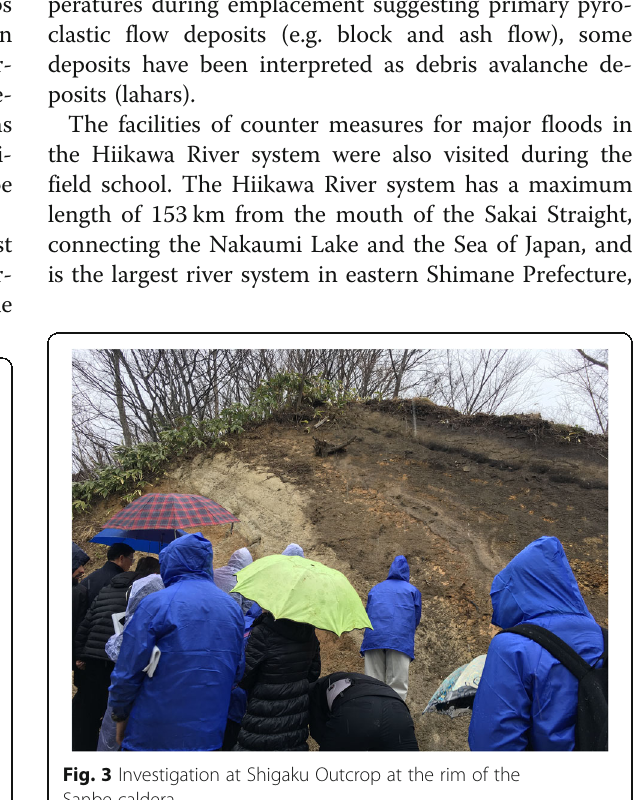
Fig. 2 Investigation at Kakeya Outcrop, SW of Unnan City